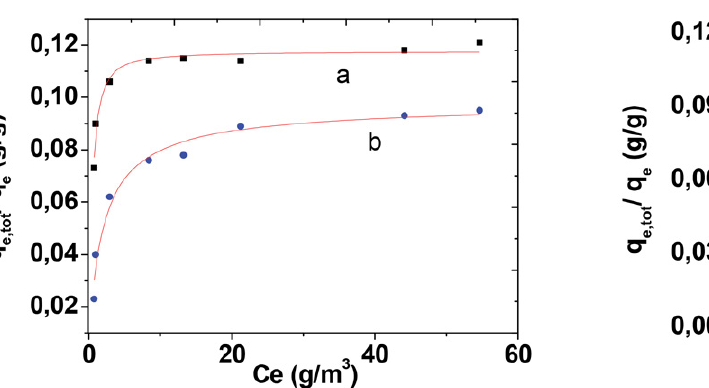
Figure 3. Adsorption Isotherms a-co-adsorption of methanol -H 2 O; b- methanol on Adsorbent 2 (rH = 60%, t = 25 °C)